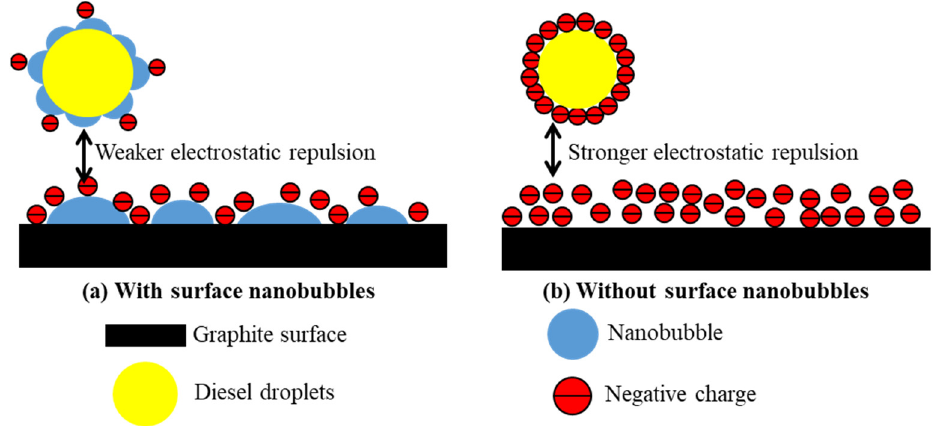
Figure 9. Illustration of electrostatic repulsion between diesel droplets and graphite surface with ( a ) and without ( b ) nanobubbles.